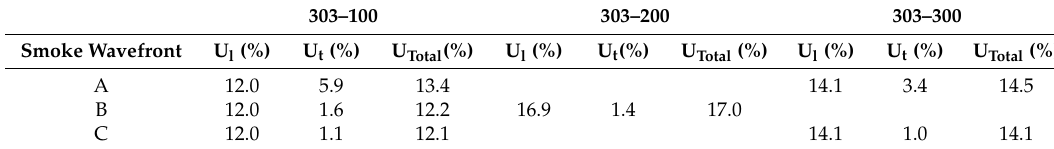
Table A7. Uncertainty calculations in smoke propagation.